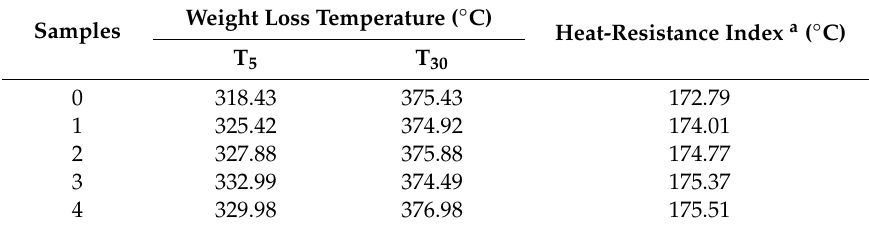
Table 1. Thermal data of the composite films from TGA analysis.